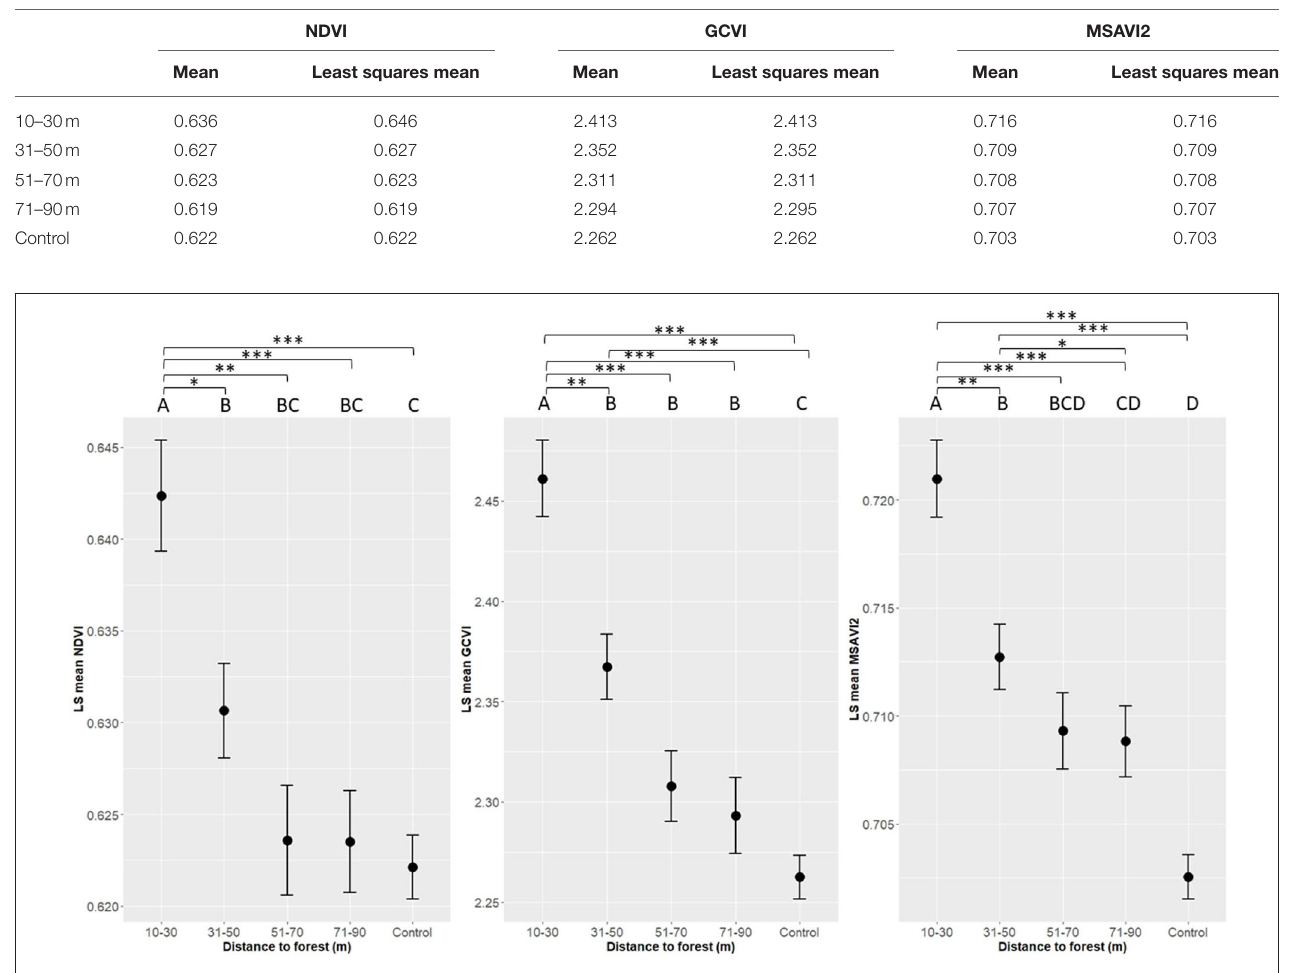
FIGURE 3 | Plot of least squares mean for NDVI, GCVI, and MSAVI in wheat fields at distances of 10–30, 31–40, 51–70, 71–90m, and control. Derived from linear model least squares means. Error bars denote standard error. n